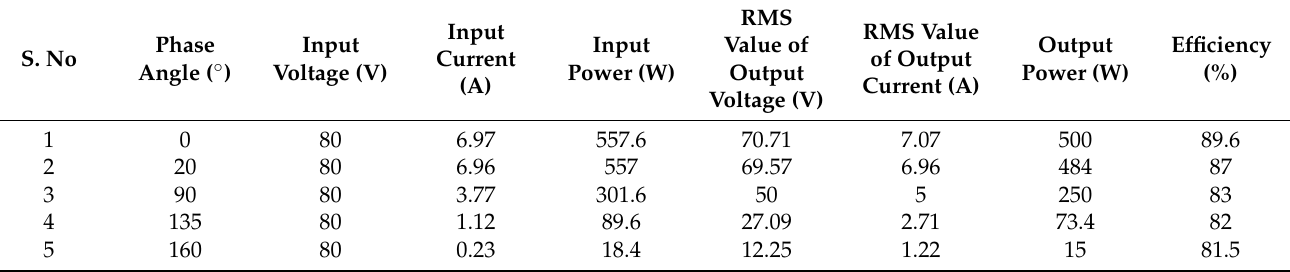
Figure 9. Phase shift control. ( a ) Switching pulses for φ = 20 ◦ . ( b ) Output voltage and current waveforms for φ = 20 ◦ . ( c ) Output voltage and current waveforms for φ = 60 ◦ . ( d ) Soft switching range. ( e ) Switch voltage and current waveforms for φ = 170 ◦ . ( f ) Temperature variation. ( g ) Heat rate for various phases angles. ( h ) FLIR thermal image for various phase angles at t = 5 min. Table 4. Efficiency of phase shift